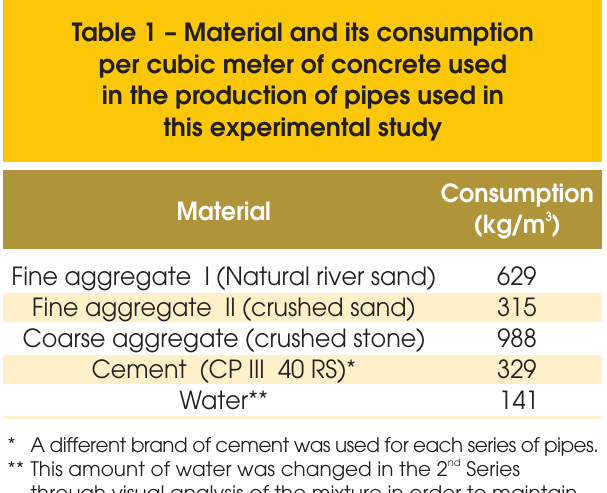
Figure 4. Rebars set up used in SBRCP production that served as a parameter for comparative performance evaluation with